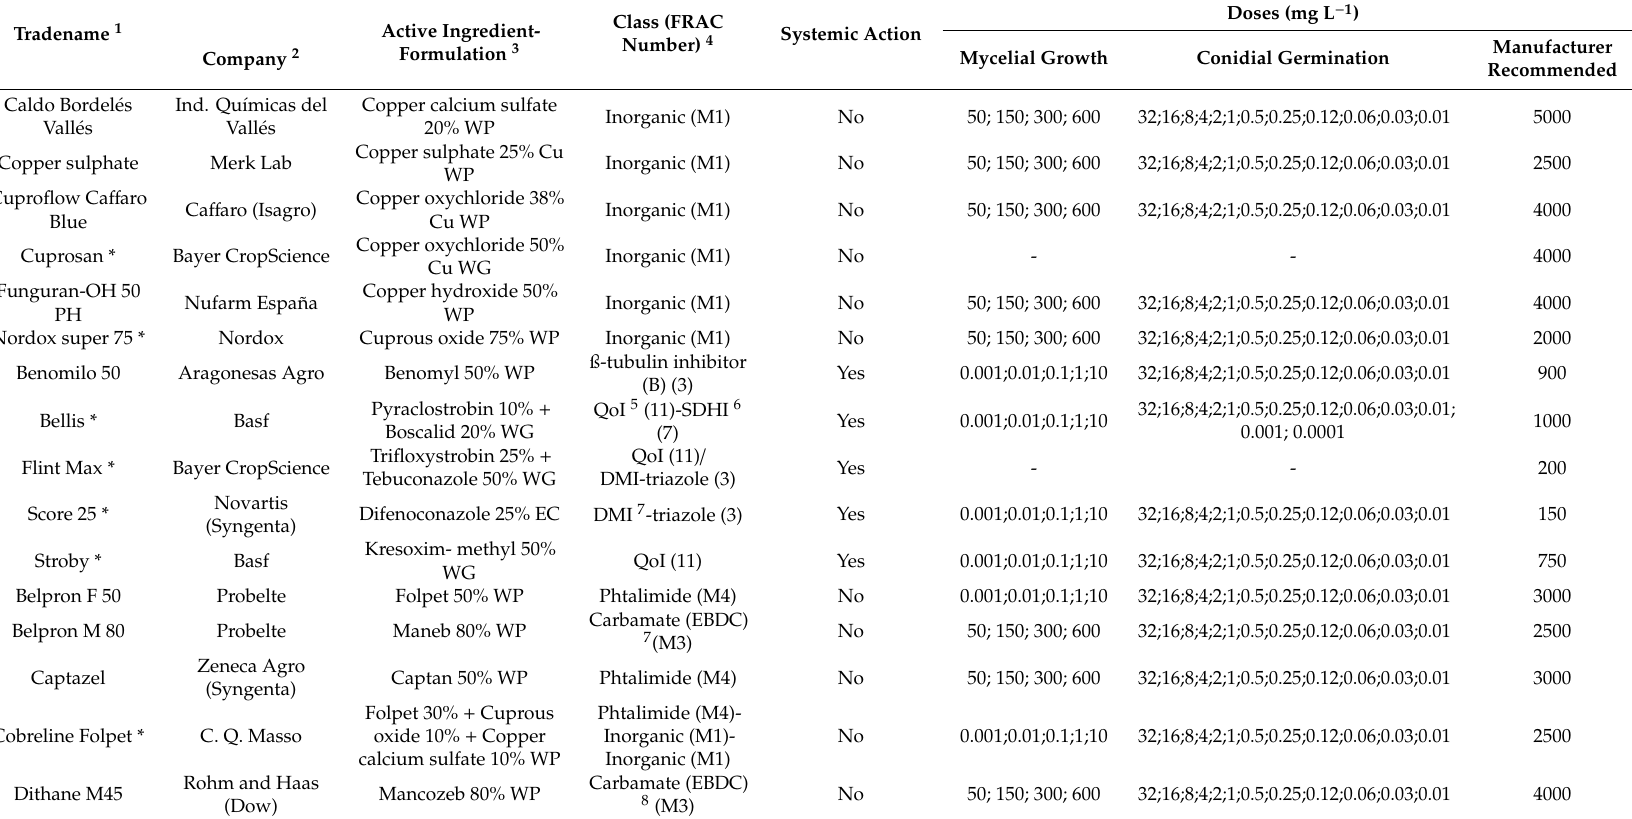
Table 1. Fungicides and dosage used in the di ff erent trials carried out in this